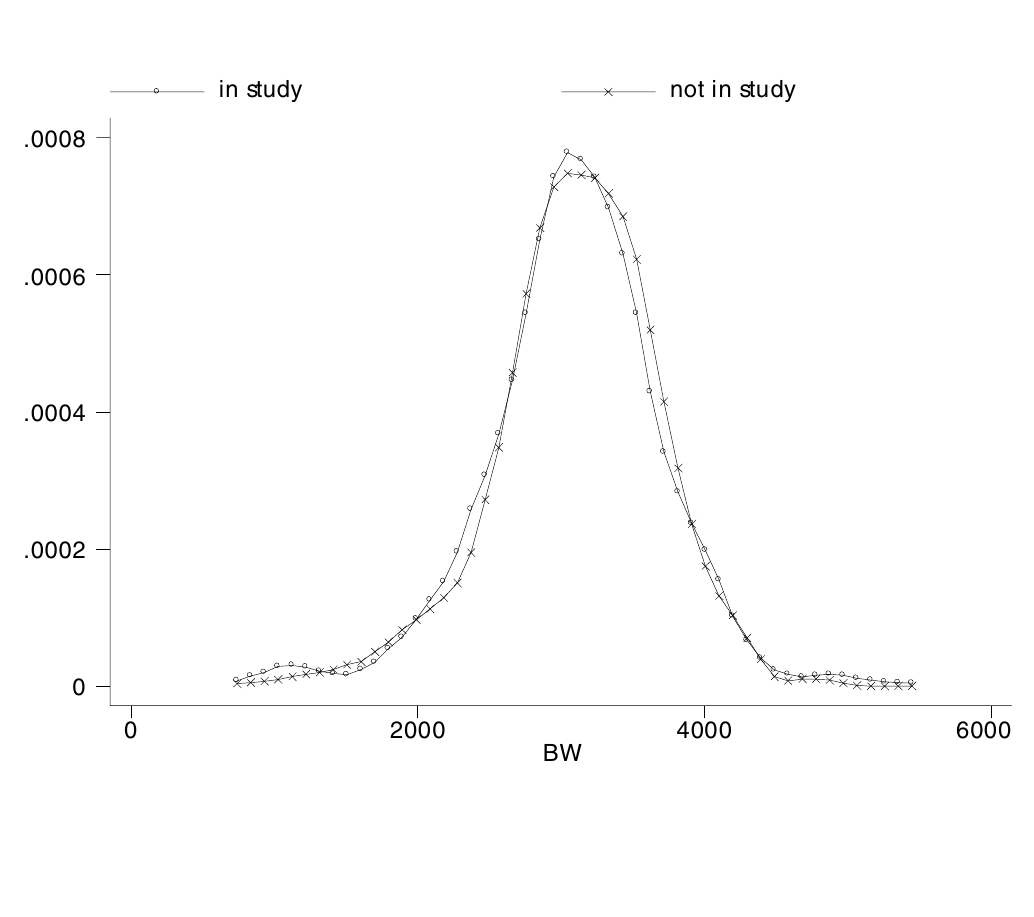
Birth weight frequencies for babies recruited and not recruited at birth into Aboriginal Birth Cohort 1987– 2001.